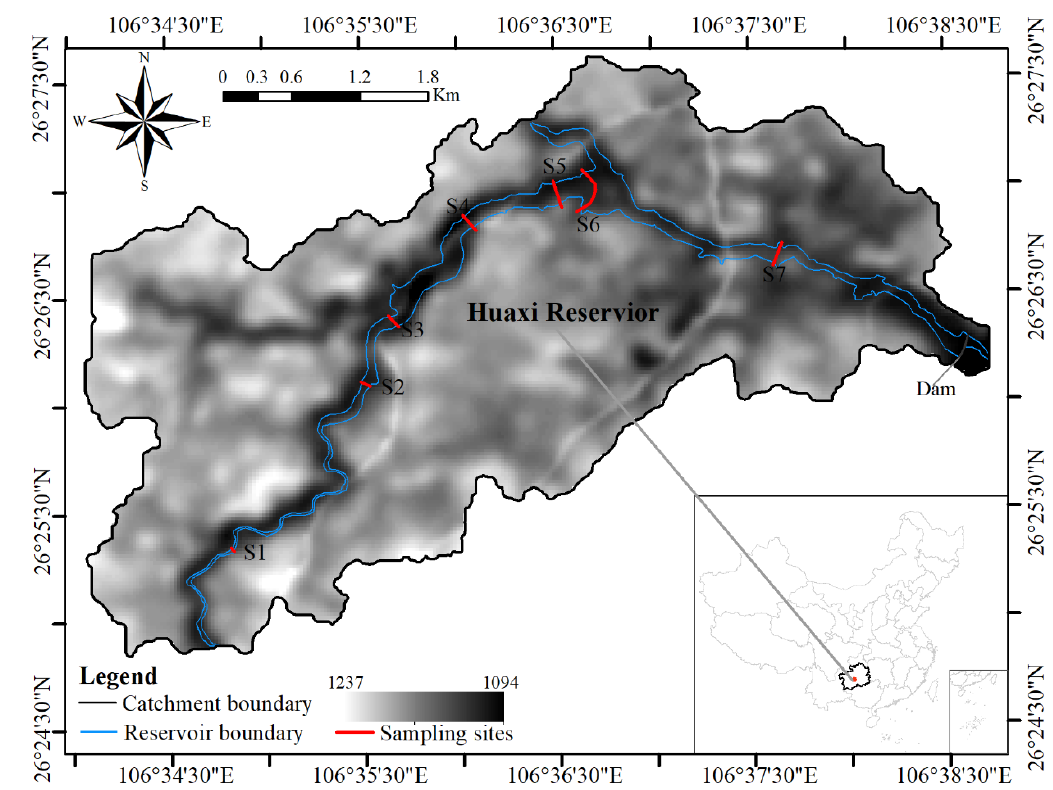
Figure 1. Sampling sites and DEM of in the catchment of Huaxi Reservoir.